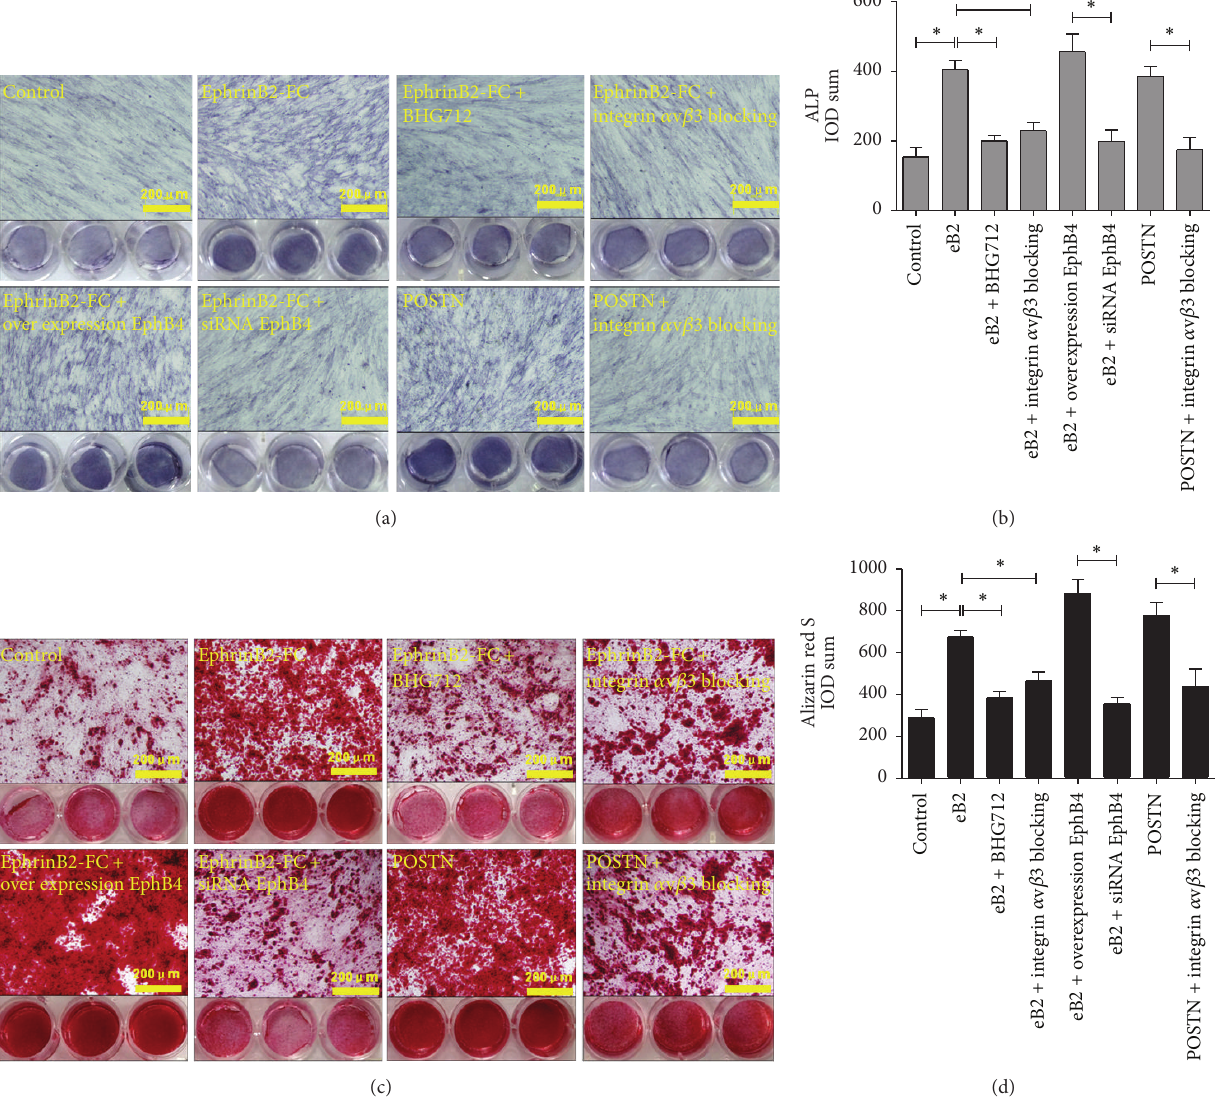
Figure 4: Evaluation of osteogenic differentiation after treatment with ephrinB2-FC or POSTN. (a) ALP staining was performed after 9 days in culture in osteogenic medium with stimulation. Untreated MSCs were used as the control. (b) The sum integral optical density (IOD) was quantified using Image-Pro Plus 6.0. Bars represent means ± SD from 3 biological replicates; ∗ 𝑃 < 0.05 . (c) Alizarin red S staining was done after 21 days in culture in the same conditions. (d) The sum IOD again was quantified by Image-Pro Plus 6.0. Bars represent means ± SD from 3 biological replicates; ∗ 𝑃 < 0.05